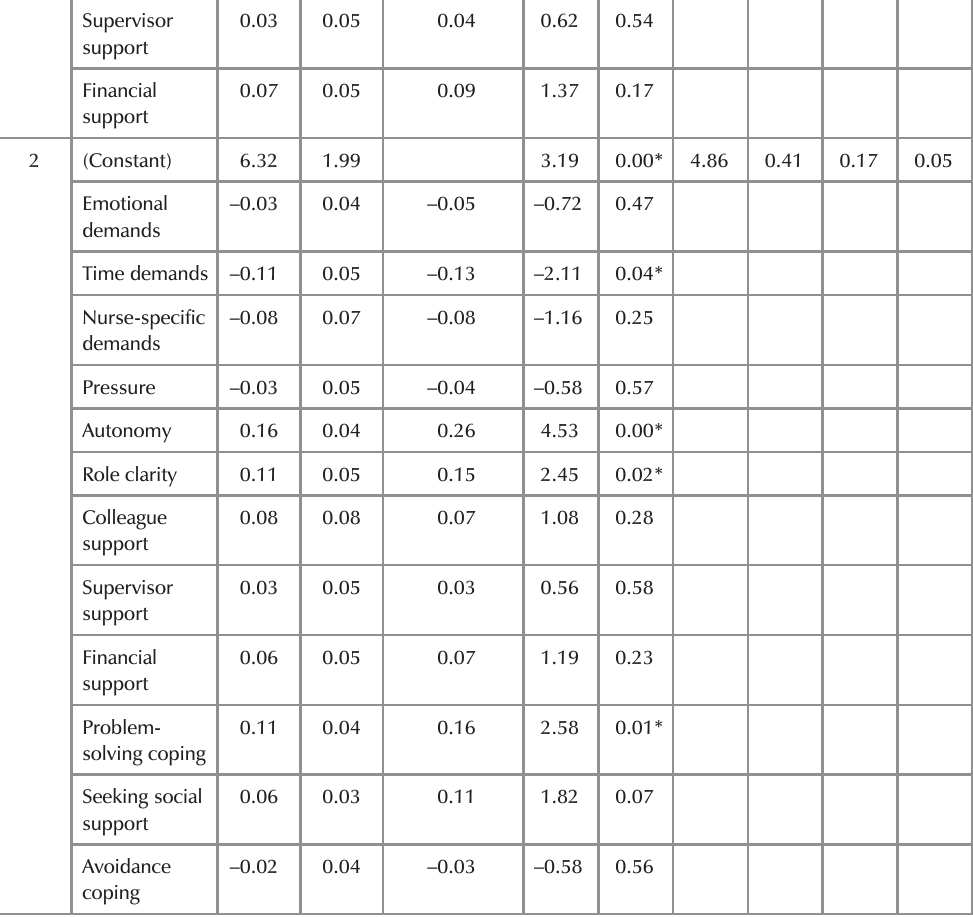
Table 4 summarises the regression analyses with job characteristics and coping strategies as predictors of positive WHI. Entry of job characteristics at the first step of the regression analysis produced a statistically significant model ( F = 4.54; p = 0.00), accounting for (9.290) approximately 12 per cent of the variance.